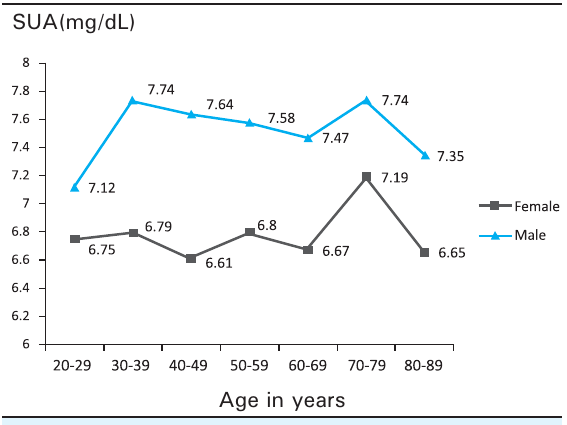
Figure 1. Age adjusted serum uric acid level among hyperuricaemic males and females